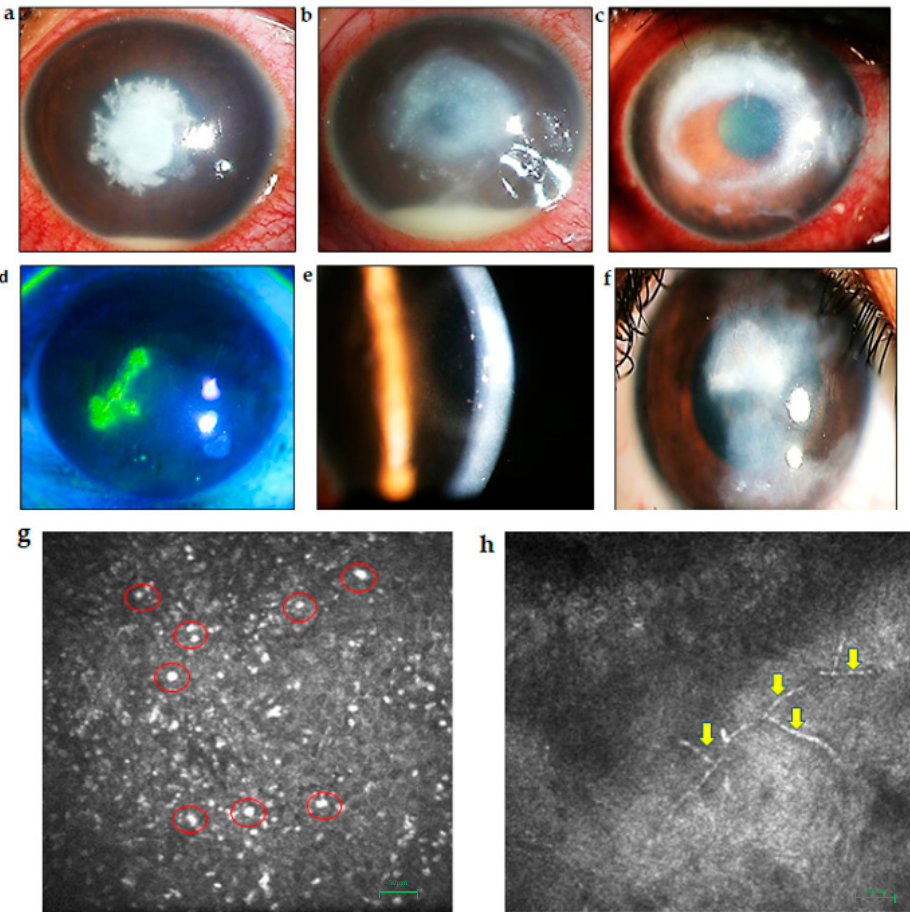
Figure 2. Slit-lamp photographs showing clinical features of different keratitis. ( a ) Fungal keratitis showing classic feathery margins and hypopyon. ( b ) Bacterial keratitis showing central dense infiltrate with hypopyon in the anterior chamber. ( c ) Acanthamoeba keratitis showing ring infiltrate in the cornea. ( d ) Herpes viral epithelial keratitis showing dendrite stained with fluorescein dye seen under cobalt blue filter. ( e ) Disciform keratitis shown with slit image of the cornea showing central stromal edema with keratic precipitates on the endothelium. ( f ) Recurrent herpes viral stromal keratitis with peripheral deep vascularization and central stromal edema and scarring. ( g ) In vivo confocal microscopy (IVCM) image of a cornea with Acanthamoeba keratitis showing hyperreflective cyst form of acanthamoeba and inflammatory cells (red circles). Panels shown are representative IVCM images with a depth of 31 microns. ( h ) IVCM image of a cornea with fungal keratitis showing fungal filaments (yellow arrows). Panels shown are representative IVCM images a depth of 320 microns. Confocal images were taken using Rostock Corneal Module/Heidelberg Retina Tomograph II (RCM/HRT2; Heidel Engineering GmBH, Dossenheim, Germany). Scale bar represents 50 µm.